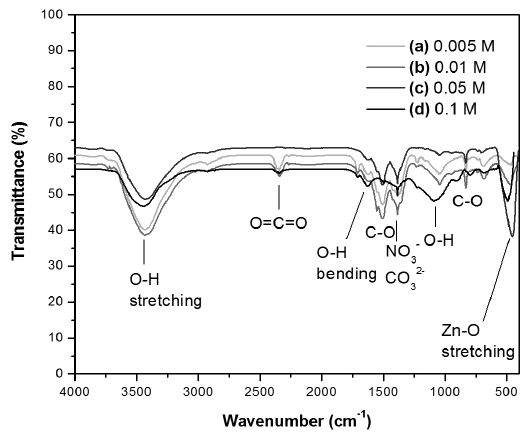
Figure 3. FITR spectra of samples: (a) F1, (b) F2, (c) F3 and (d) F4.